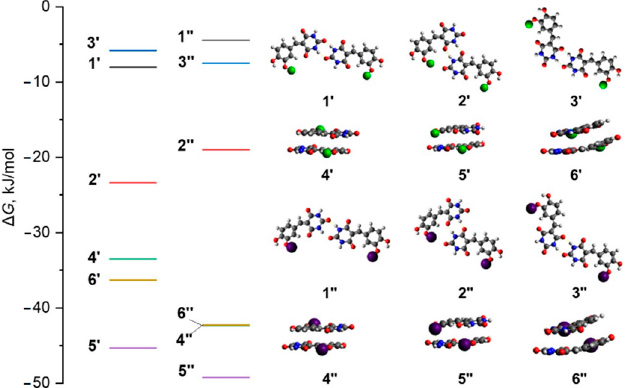
Figure 2. Calculated Gibbs energies of possible dimer structures of compounds 3a ( 1 ′ – 6 ′ ) and 3b ( 1” – 6” ). Green/violet spheres indicate Me/Et groups.